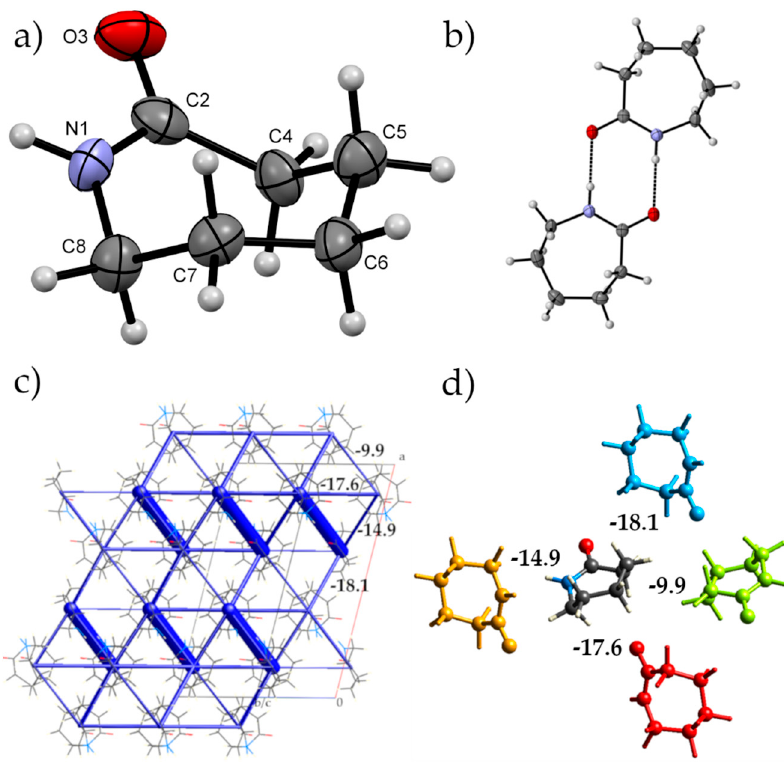
Figure 1. ( a ) Numbering scheme for ε -caprolactam highlighting the chair conformation that the molecule adopts in the crystal structure under ambient conditions ( b ) The amide dimer hydrogen-bonding interaction between two ε -caprolactam molecules that is observed in the crystal structure ( c ) The total interaction energy framework of ε -caprolactam as calculated by CrystalExplorer [25]. The thickness of the framework indicates the strength of interaction (dimer interaction: − 68.2 kJ·mol − 1 ). Other interaction energies between the dimers are indicated. ( d ) The top four non-hydrogen bonding interactions of the central molecule with nearest neighbours (values are in kJ·mol − 1 ).